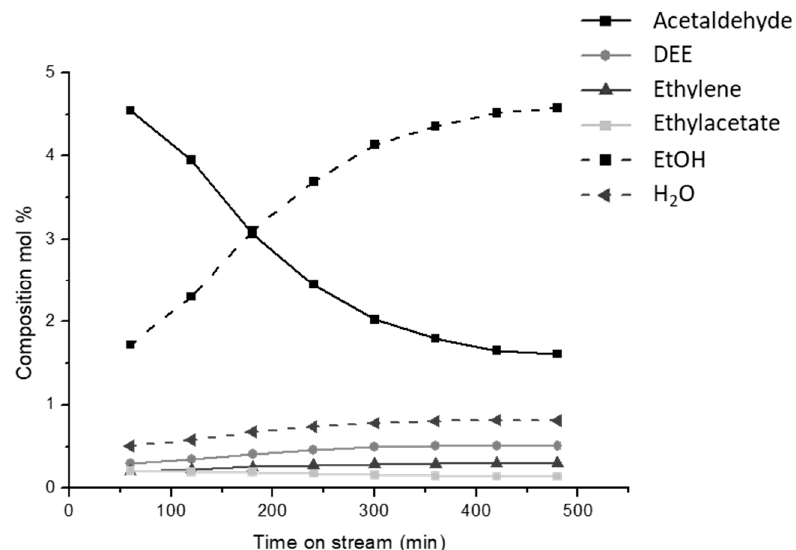
Figure 6. Effect of the time on stream for the ethanol conversion 9.1% CuO/ZnAl 2 O 4 catalyst at 623 K in terms of molar composition at a weight hourly space velocity (WHSV) = 12 h − 1 .